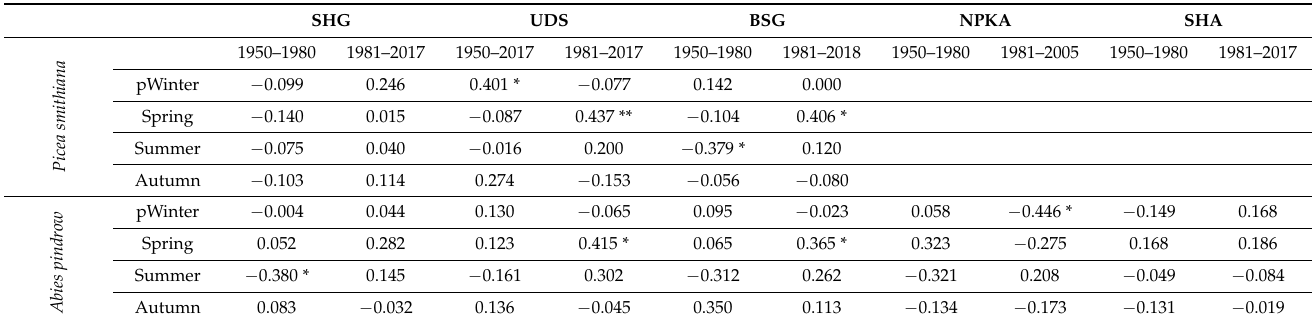
Table 5. Correlation coefficients between seasonal precipitation and the tree-ring index of spruce